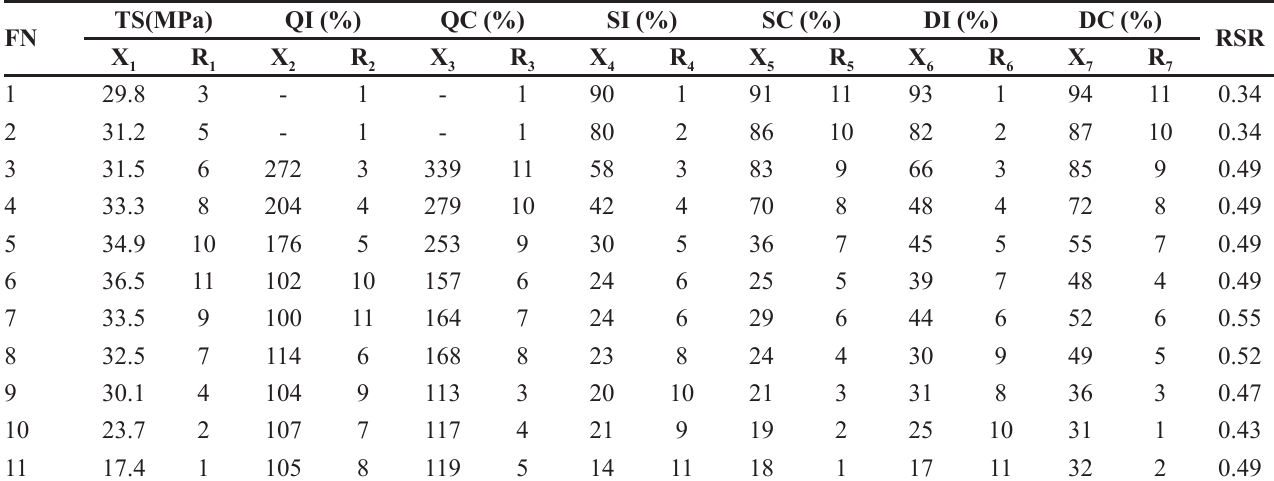
TABLE III - Results of the RSR Test